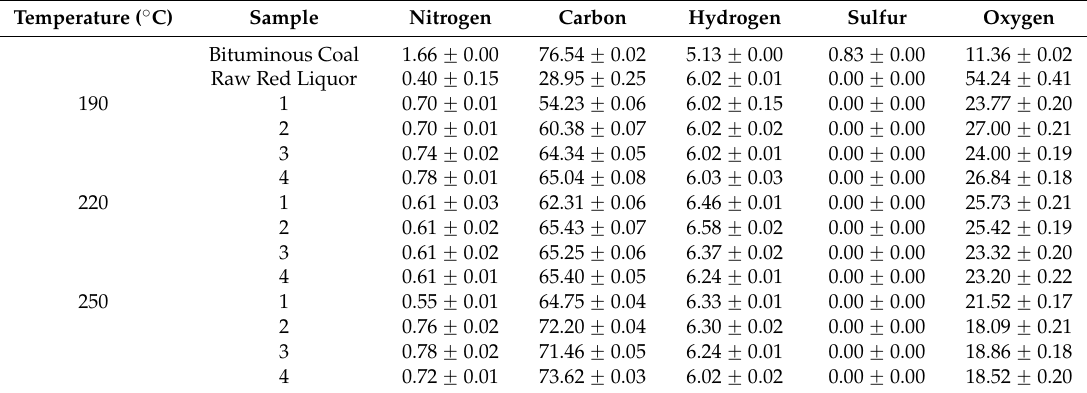
Table 1. Ultimate Analysis of the Hydrochar Samples (wt.% d.b.).